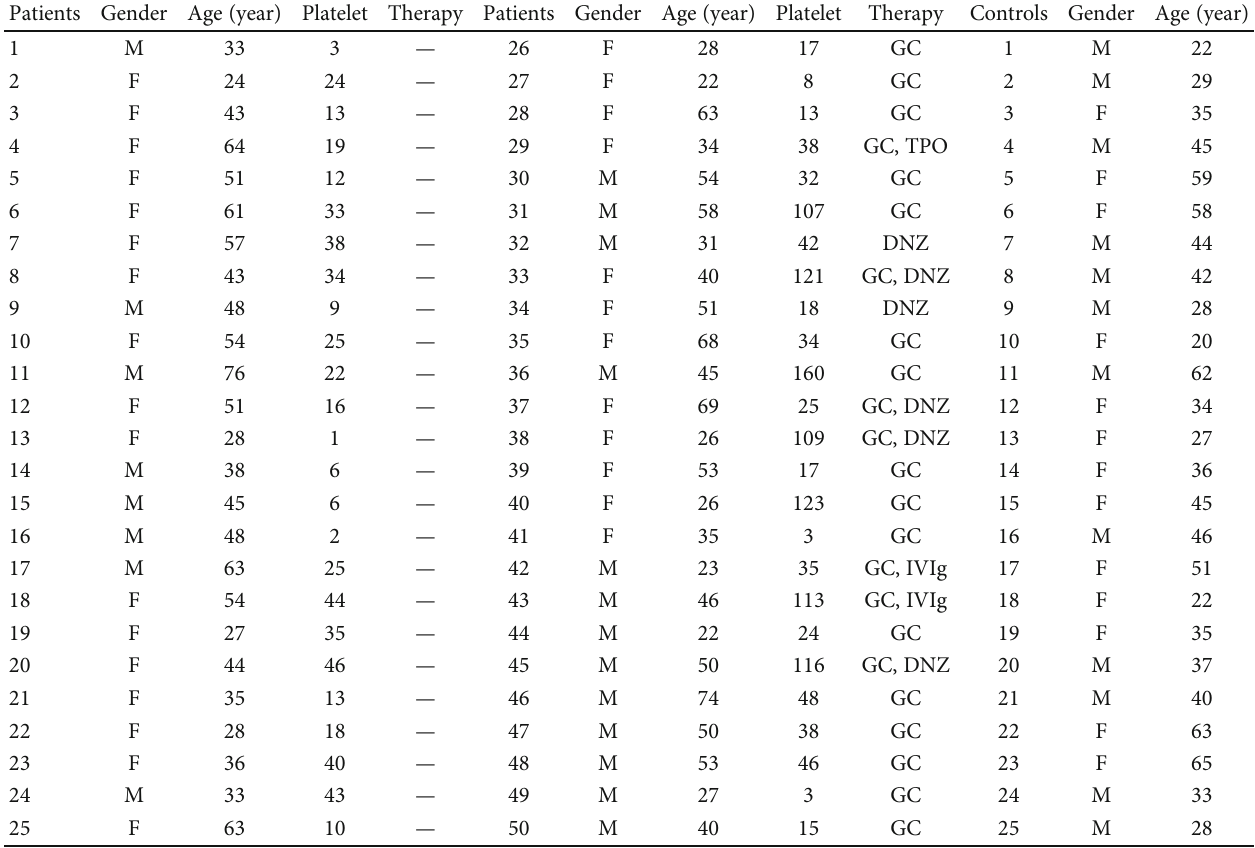
Table 1: Basic characteristics of ITP